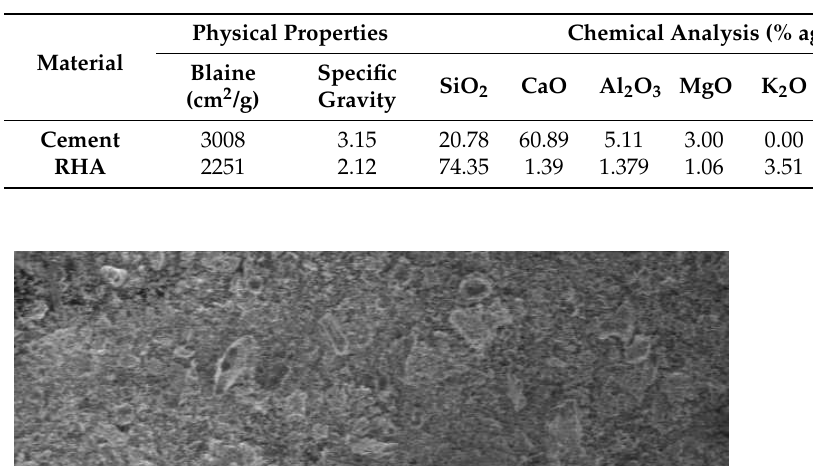
Table 1. Properties of OPC and optimized Rice Husk Ash (RHA).